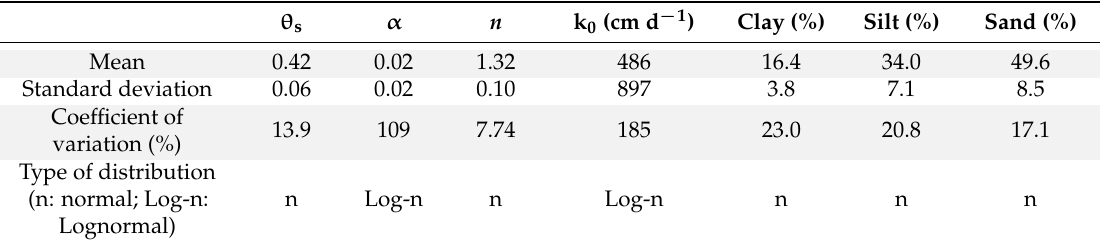
Table 1. Statistics of the parameters of soil hydraulic properties and texture of Ap horizon. θ s α n k 0 (cm d − 1 ) Clay (%) Silt (%) Sand